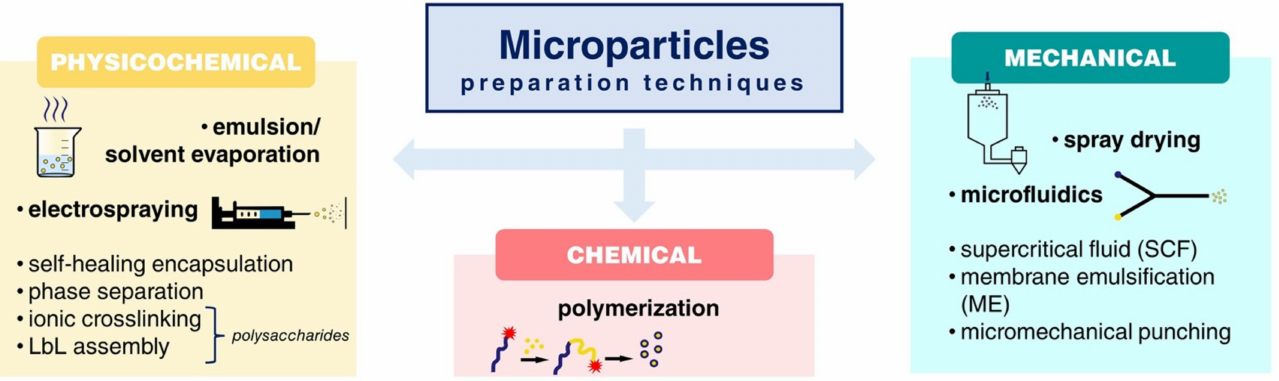
Figure 1. A schematic overview of different techniques for MP